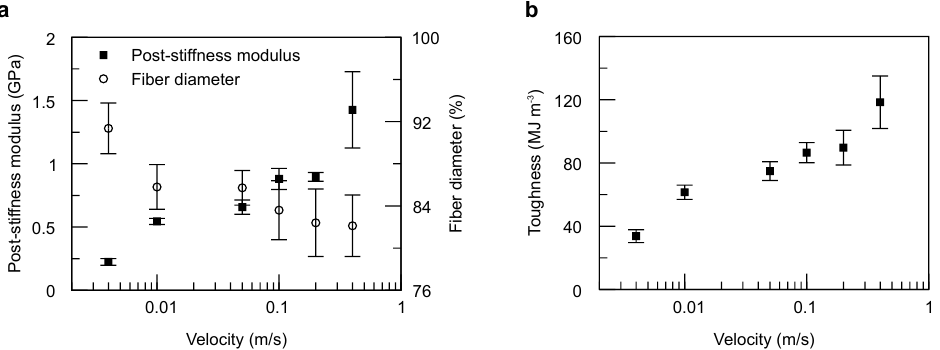
Figure 6. Depicted here are the variations in post-stiffness modulus and fiber diameter ( a ), and breaking energy ( b ), with respect to velocity. Each data point stands for an average with standard error taken from four different silk fiber random arrangement